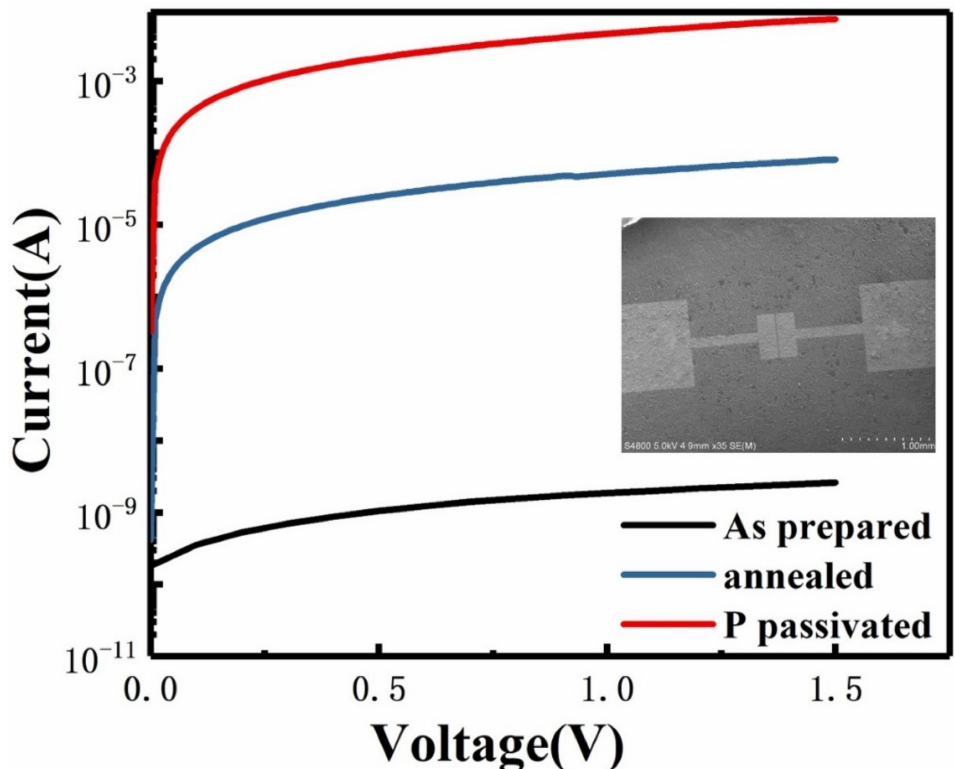
Figure 5. I–V characteristics of as-prepared (black line), annealed (blue line) and P passivated (red line) silicon nanosheets with SEM image of two-end device as